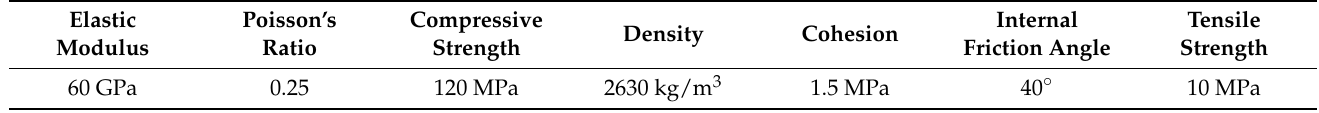
Figure 2. Numerical simulation model. Table 3. Rock mass parameters of Lac Du Bonnet granite in the mine-by test tunnel.